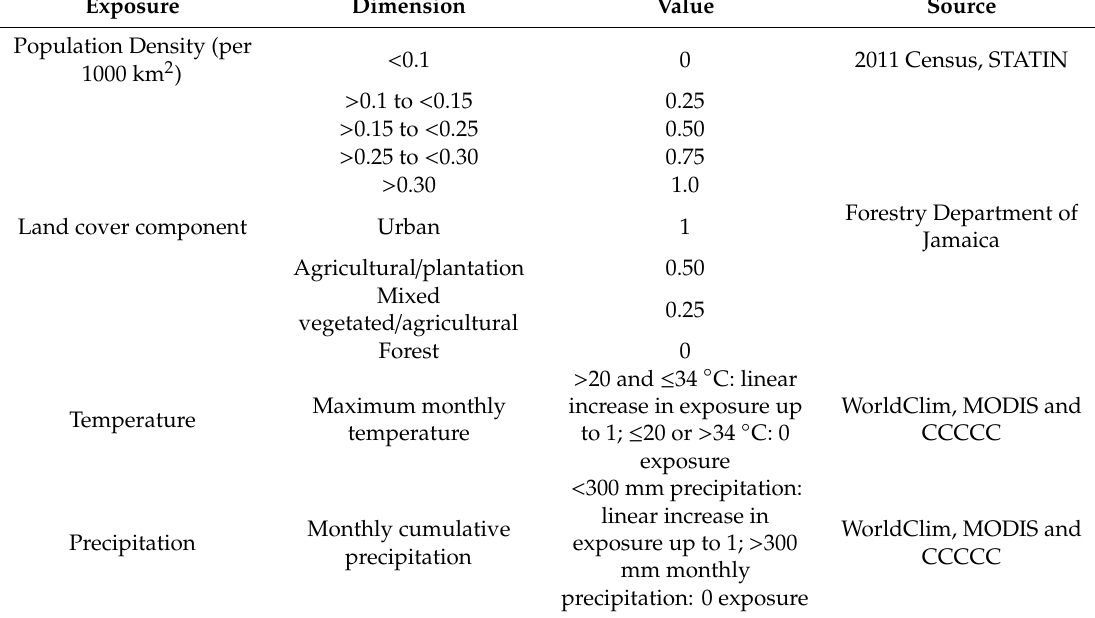
Table 1. Exposure indicator used for Water-Associated Disease Index (WADI).